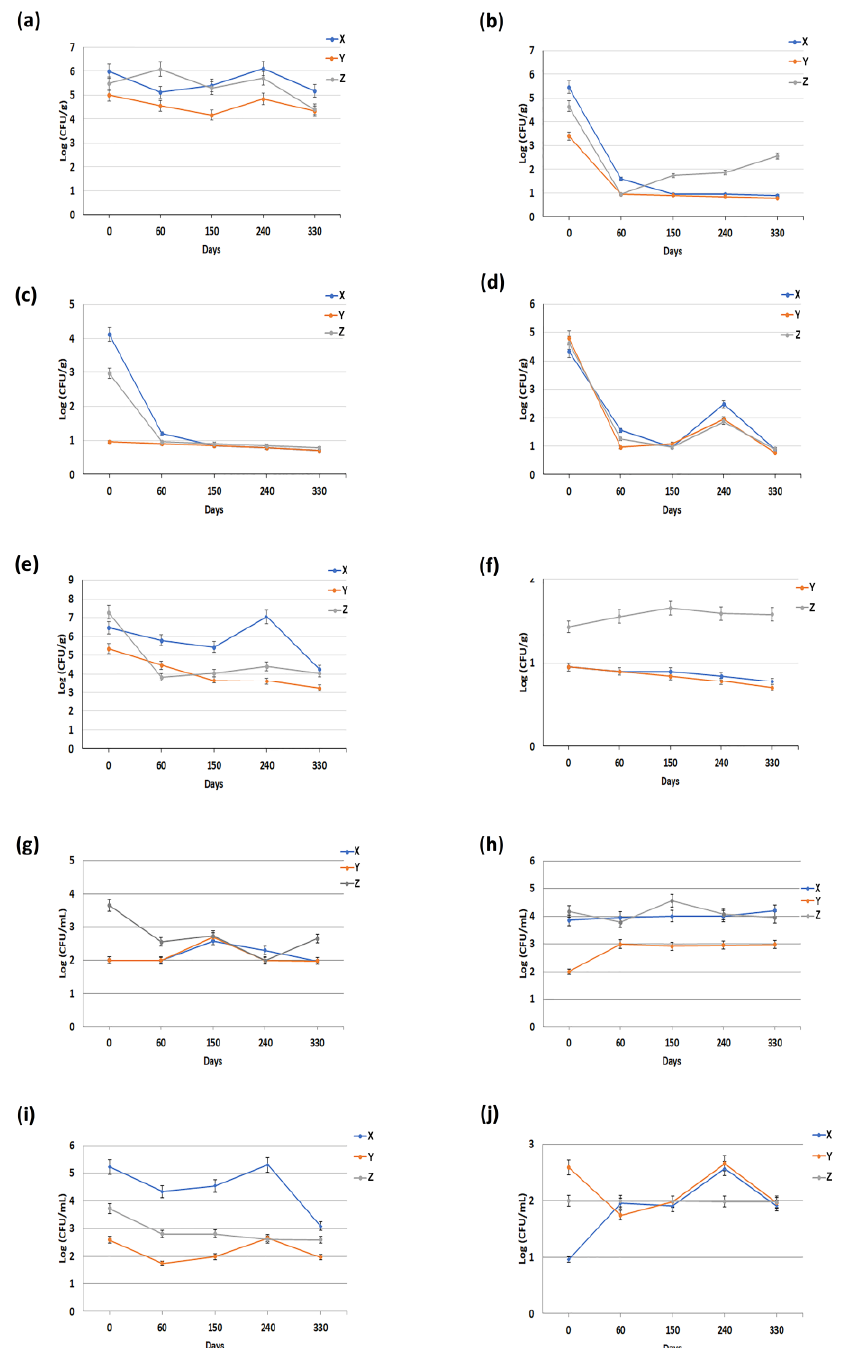
Figure 2. Microbiological data on mature curd collected from three different dairies (X, Y and Z). Quantification of: ( a ) total bacterial count; ( b ) coliforms; ( c ) Escherichia coli ; ( d ) Enterobacteriaceae ; ( e ) lactic acid bacteria; ( f ) coagulase-positive staphylococci; ( g ) Pseudomonas spp.; ( h ) psychrotrophic; ( i ) yeasts and ( j ) moulds. Each datum represents the mean ± SD of the different microbiological analyses, each performed in